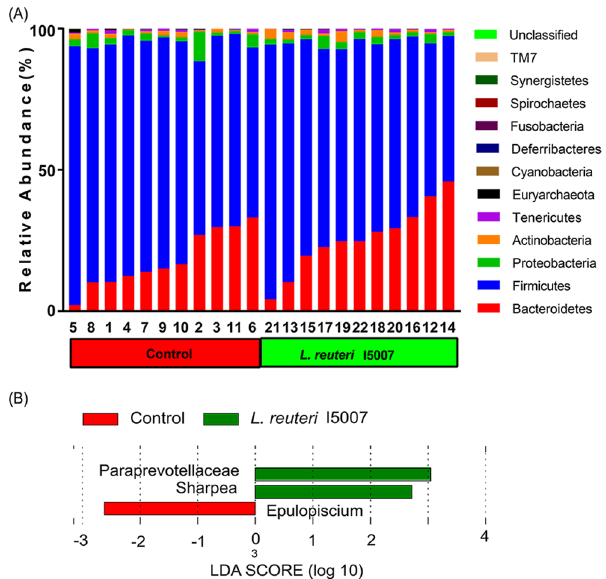
Figure 5. Effects of L. reuteri I5007 on bacterial community structure in colonic digesta. ( A ) Relative abundance levels of the bacterial phyla present in control group and L. reuteri I5007 group; ( B ) Histogram of the LDA scores computed for taxa differentially abundant between control and L. reuteri I5007 treated piglets ( n = 11).